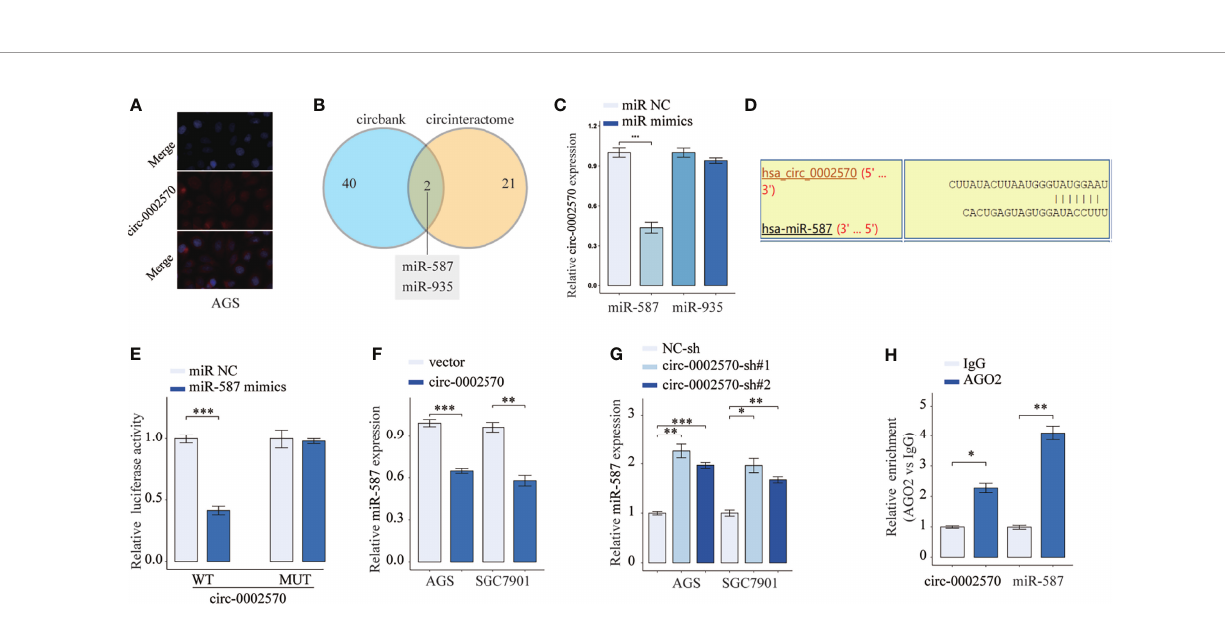
FIGURE 5 | Circ-0002570 competitively sponged miR-587. (A) Representative FISH images indicated subcellular location of circ-0002570 in AGS cells. (B) Intersection of miRNAs predicted by circBank and CircInteractome databases. (C) RT-PCR examined the expression of circ-0002570 in AGS cells after miR-587 or miR-935 overexpression. (D) The binding sites of circ-0002570 and miR-587. (E) Luciferase reporter assay con fi rmed the molecular binding. (F) Overexpression of circ-0002570 resulted in the suppression of miR-587 expression. (G) Silence of circ-0002570 promoted the expression of miR-587. (H) RIP assays determined the combination between circ-0002570 and miR-587. * p < 0.05, ** p < 0.01, *** p < 0.001.